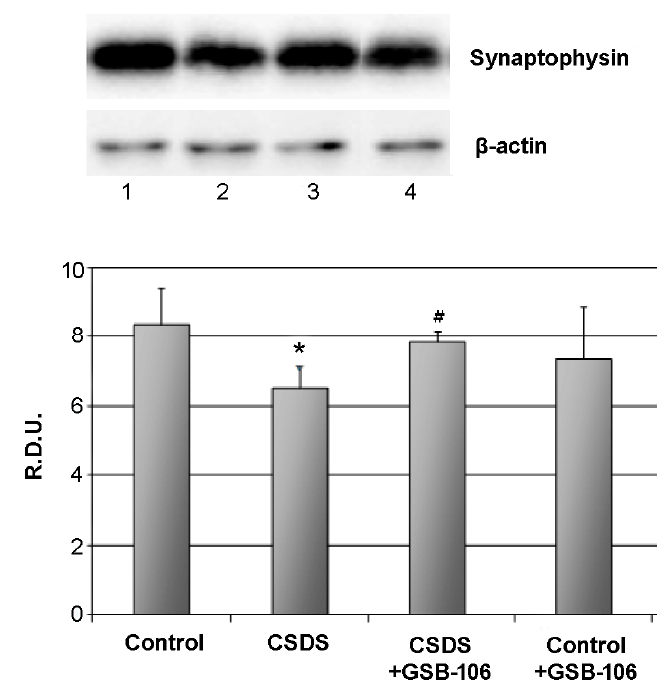
Figure 2. Dipeptide GSB-106 restores decreased synaptophysin level in hippocampus of CSDS mice.Western blot analysis data. R.D.U—relative densitometric units. Lanes: 1—Control, 2—CSDS,